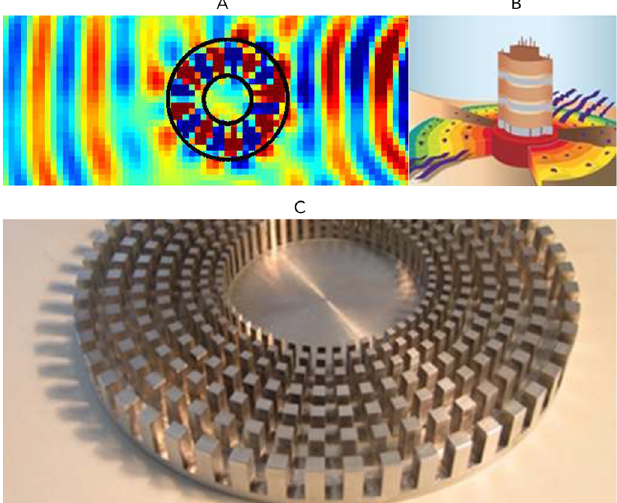
Fig. 2. Cloaking and wave analogies: water waves, [23] and also microwaves and sound waves [24], experiments have all been performed with the same geometrical cloak. The metamaterial cloak works over a fi nite interval of wave wavelengths that do not exceed the cloak ’ s diameter (20 cm) and for which the cross- section of its structural elements can be considered small enough (not exceeding one third of the wavelength); (A) microwave experiment (courtesy of R. Abdeddaim and E. Georget, Institut Fresnel) showing both reduced fi eld in the centre of the cloak and cloak ’ s transparency for a transverse electric wave at 3.5 GHz [24]; (B) artistic view of a seismic cloak (Institute Fresnel/INSIS/ CNRS); (C) photo of the fabricated aluminium cloak (courtesy of S.